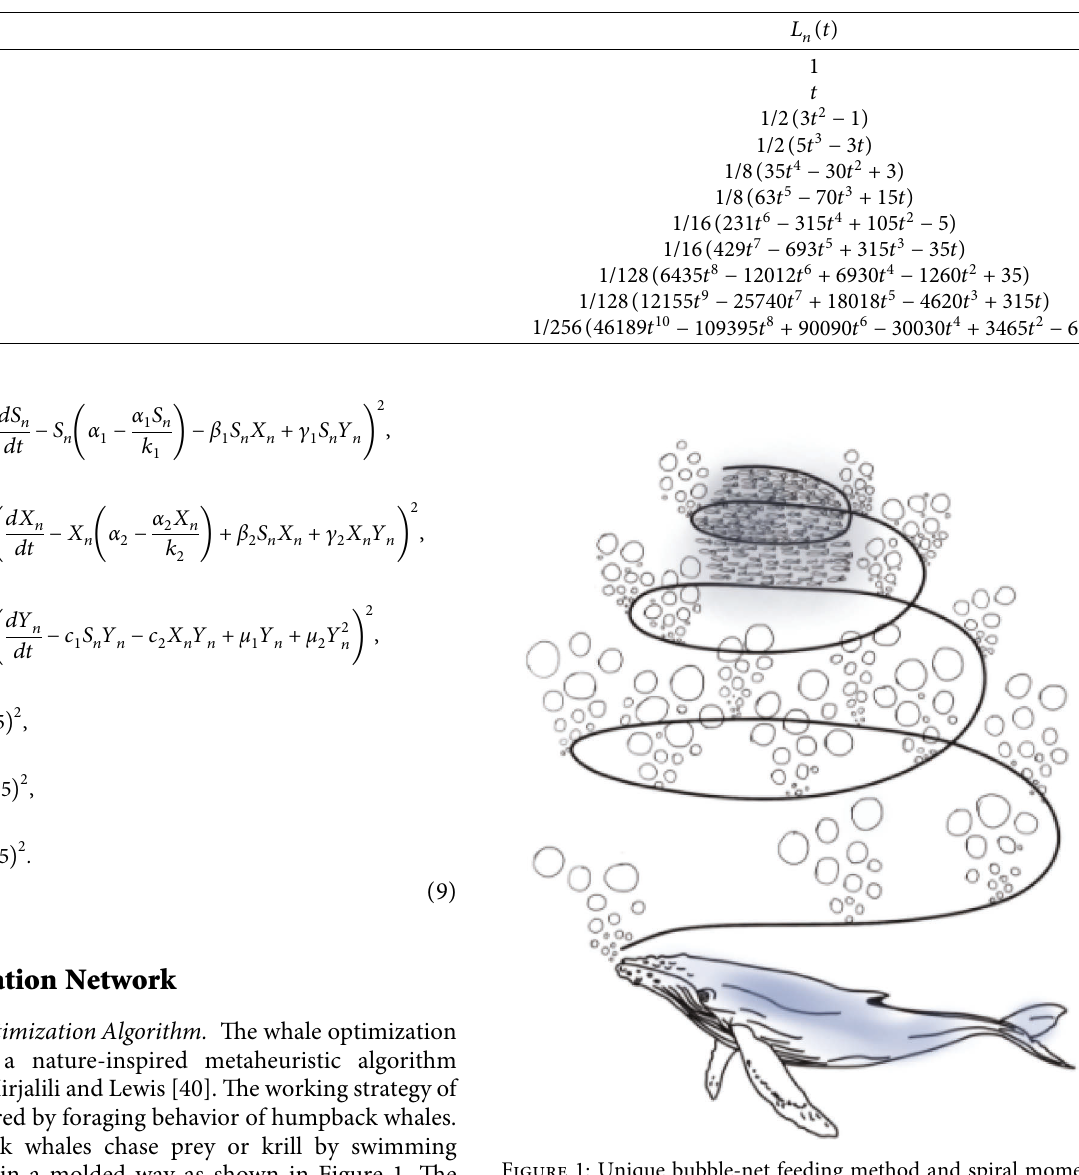
Table 1: Eleven Legendre polynomials with an independent variable t .